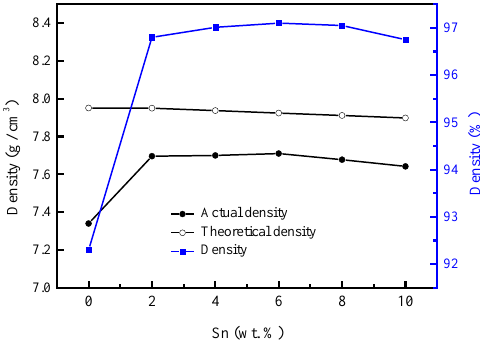
Figure 4. Density of the matrix of sintered samples with different Sn contents.